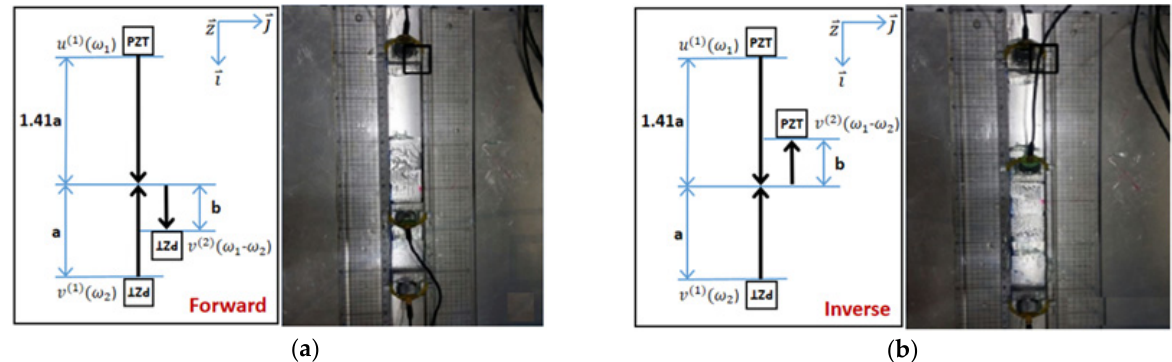
Figure 8. Experimental setup with S1, A1 modes and two directions: ( a ) Forward direction S1, A1 modes; ( b ) Inverse direction S1, A1 modes ( a = 100 mm and | b | = 20 mm).